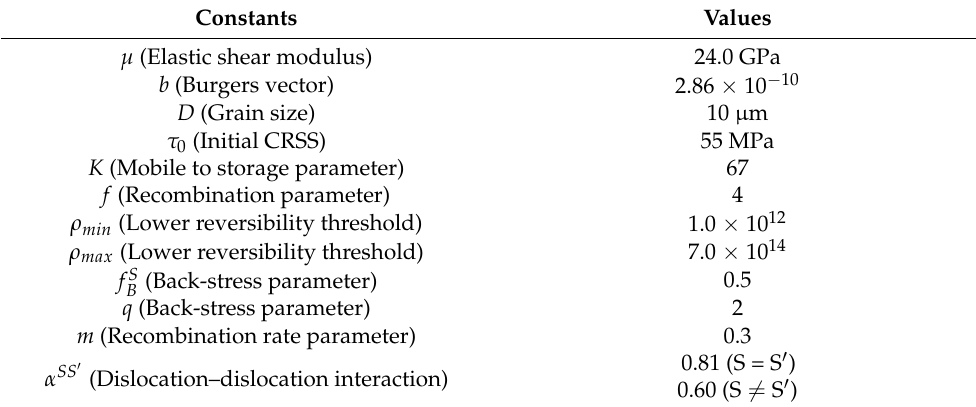
Table 3. Material constants of the DDR model for the AA6061-T4 alloy. Constants